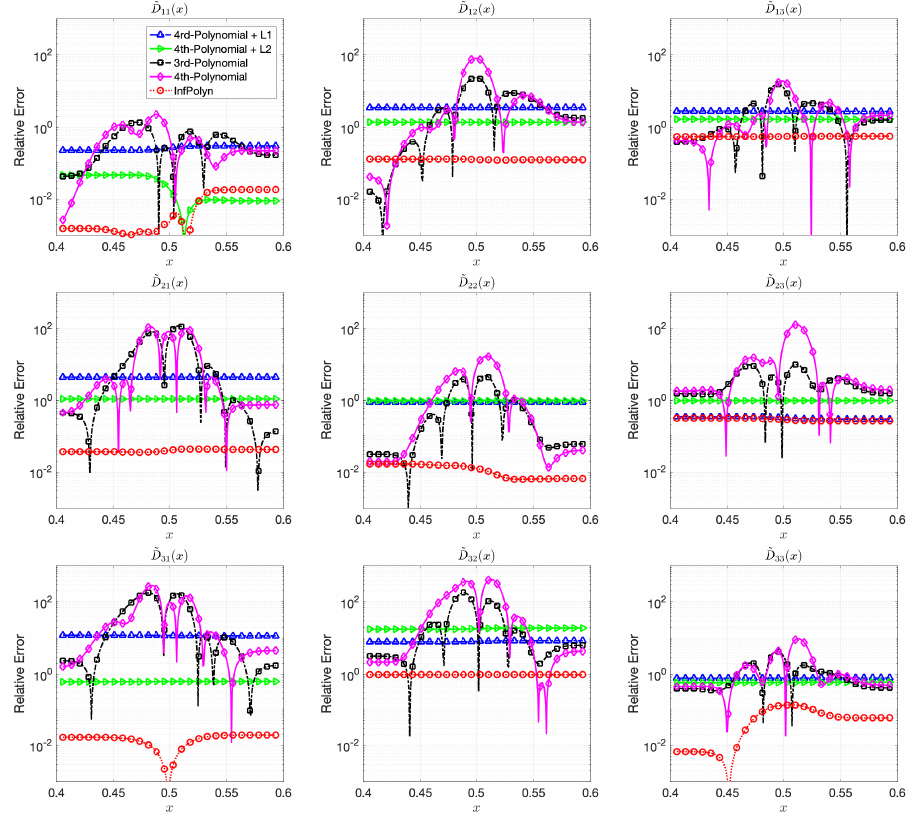
Figure 2. The relative errors (REs) of predictive diffusion coefficients ˜ D ij ( c ( x )) in the center areas x ∈ [ 0.4,0.6 ] for the evaluated methods in a quadternary